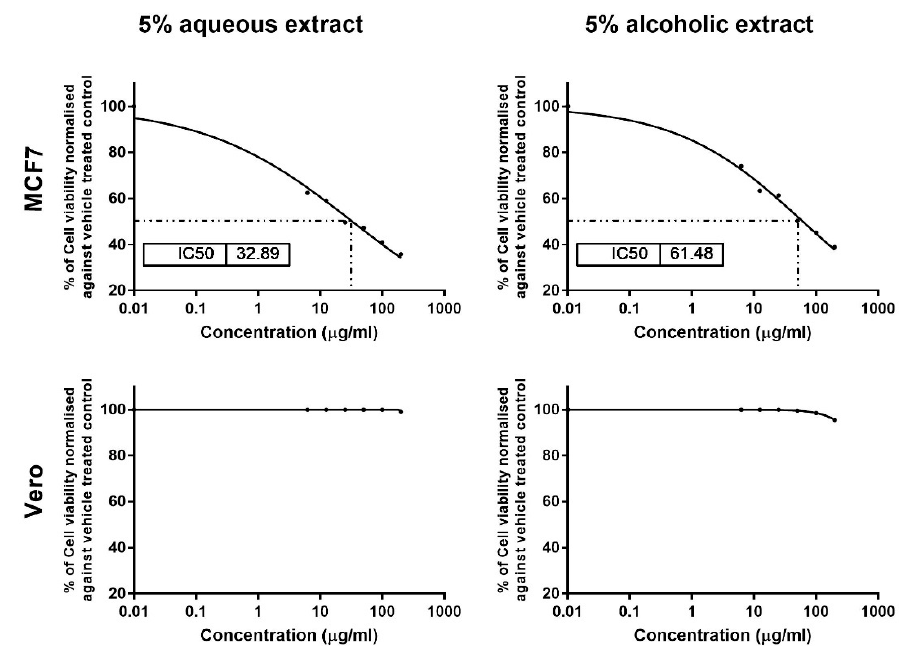
Figure 3. Cytotoxicity analysis of the 5% larval extracts using the MTT assay. Dose–response curves show the effect of the two extracts on MCF7 and Vero viability and the obtained IC 50 after 24 h. Data were normalized to untreated control cells and expressed as the mean % viability ± SEM. Samples on MCF7 and Vero were run in triplicate in three independent experiments, n = 5.